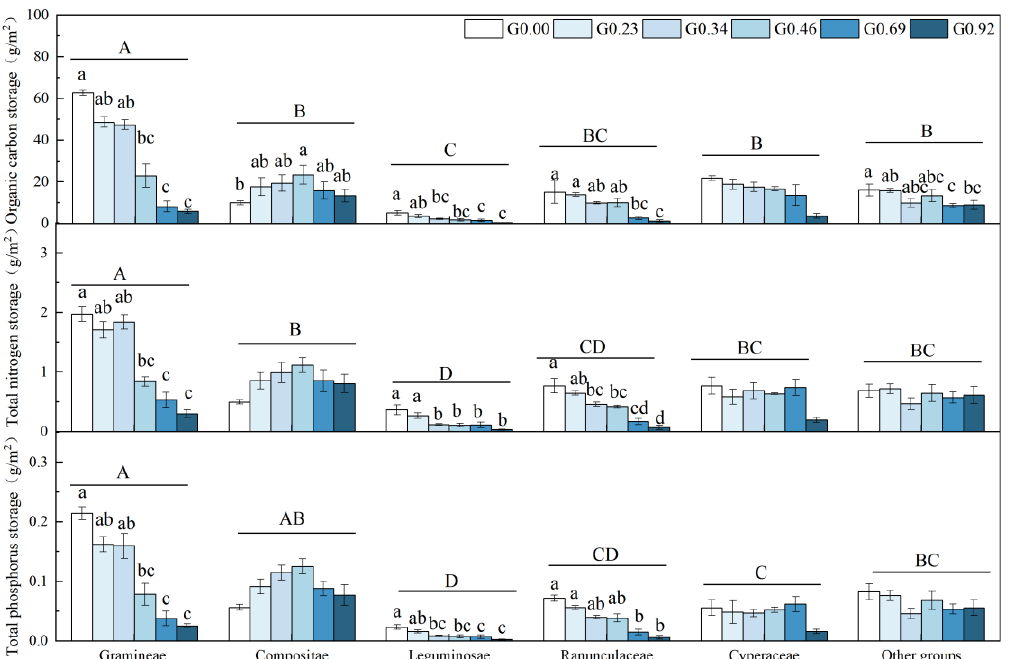
Figure 4. Variation in nutrient storage amounts of plant functional groups under different grazing intensities. Note: Lowercase letters represent significant differences between different grazing intensities, and uppercase letters represent significant differences between functional groups ( p < 0.05).